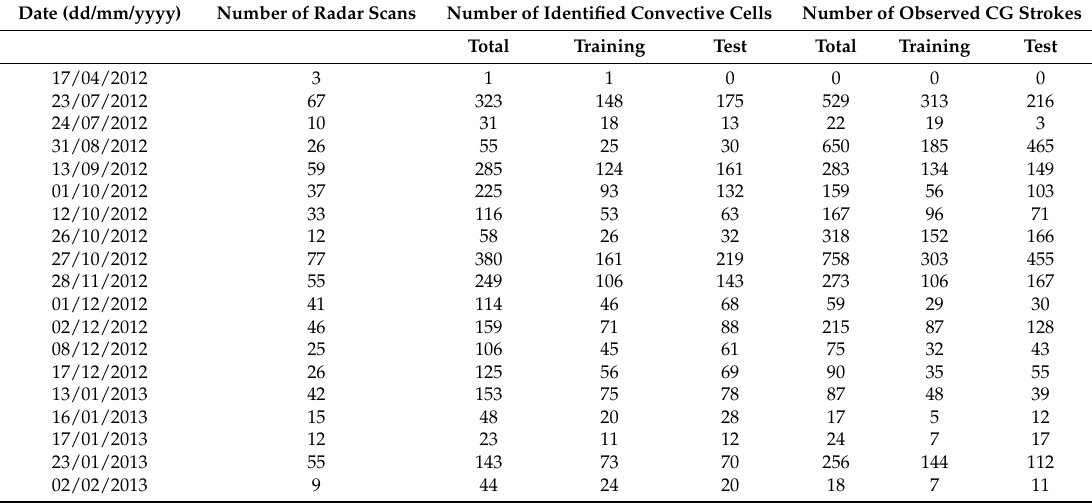
Table A1. For each of the thunderstorm days considered in this study, the following information is presented: the number of analyzed radar scans, the number of identified convective cells and the number of observed CG strokes, with the last two partitioned in terms of training and test dataset. Date (dd/mm/yyyy) Number of Radar